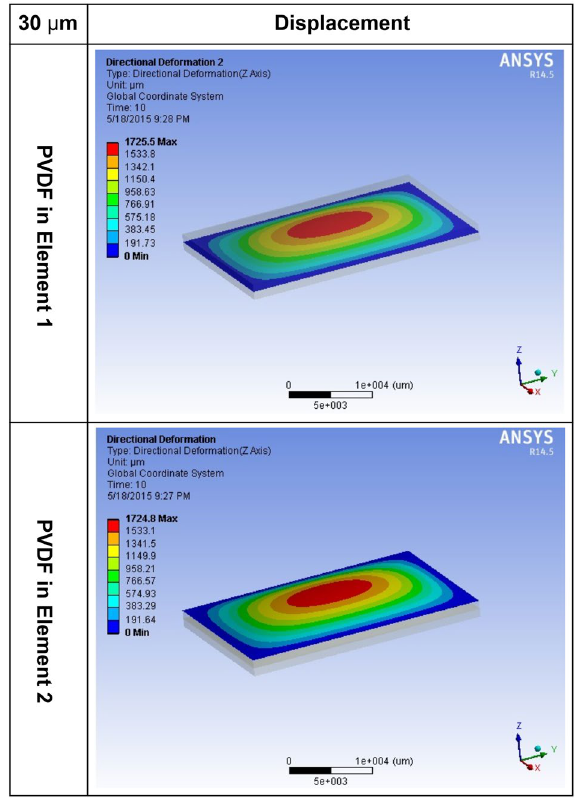
Figure 2. ANSYS result of Elements 1 and